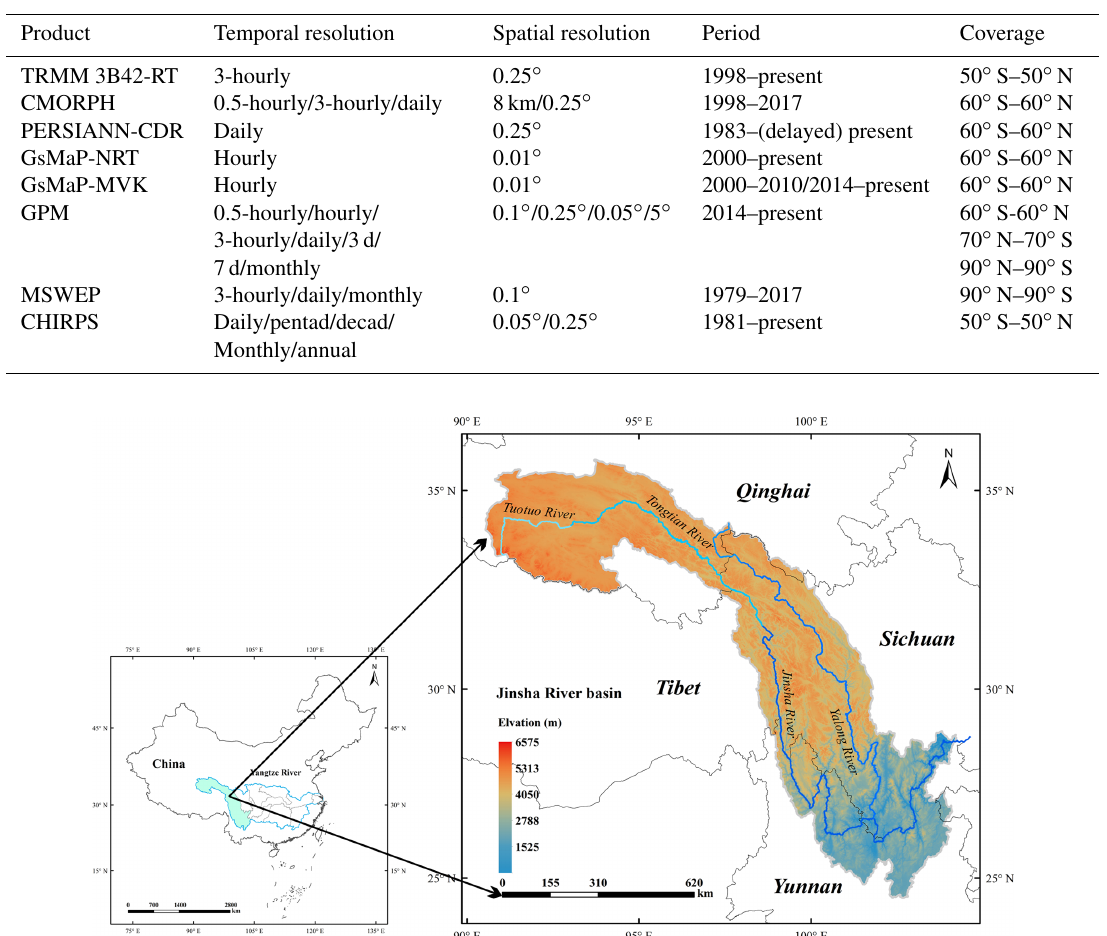
Figure 1. Location of the study area with key topographic